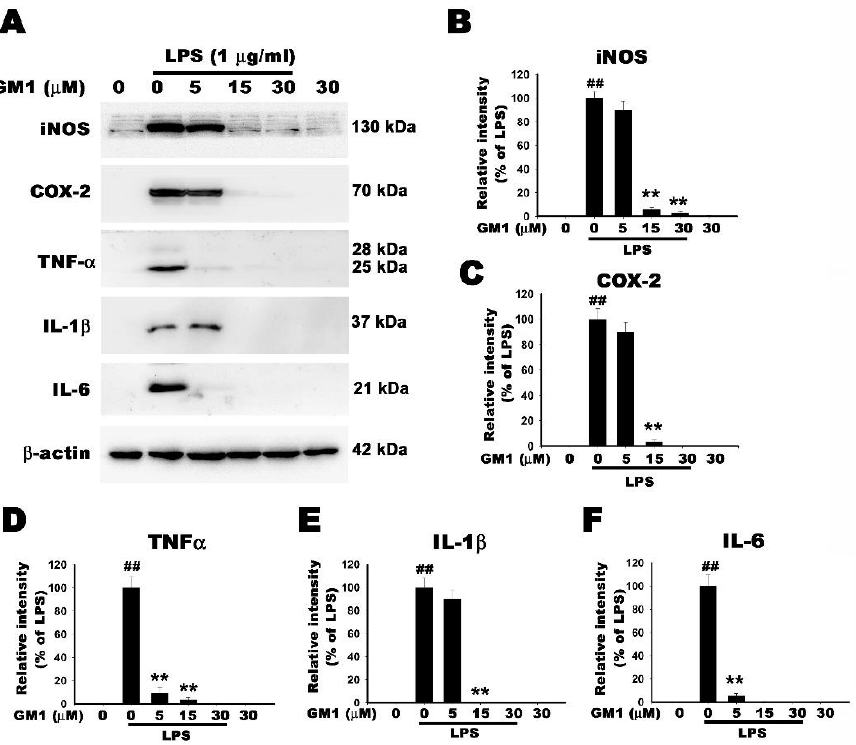
Figure 7. Effect of GM1 on the protein levels of proinflammatory mediators in LPS-stimulated RAW 264.7 cells. ( A ) Cells were pretreated with different concentrations of GM1 (5, 15, 30 μM) for 1 h, stimulated with LPS (1 μg/mL) for 8 h, and then subjected to Western blot analysis with anti-iNOS, anti-COX-2, anti-TNF- α, anti -IL- 1β and IL - 6 antibodies; β -actin was used as an internal control. ( B – F ) The protein bands from each treatment group were quantified using densitometry. Data are presented as percentages of the LPS-treated group (mean ± S.D., n = 3). ## p < 0.01 compared with the control group; ** p < 0.01 compared with the LPS-treated group.